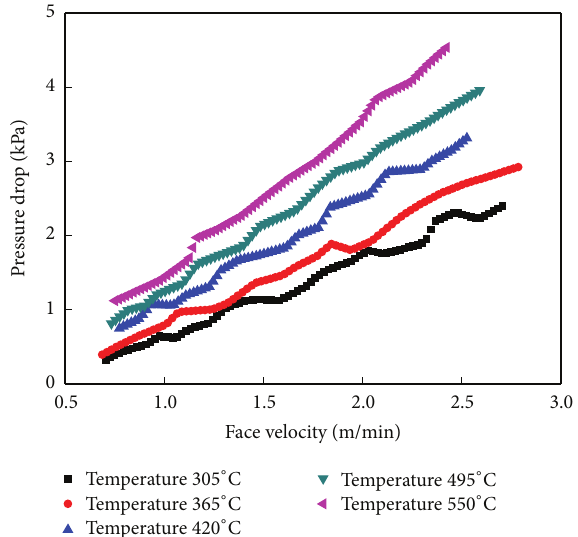
Figure4:Evolutionoftheinitialpressuredropwiththefacevelocity at five temperature levels.